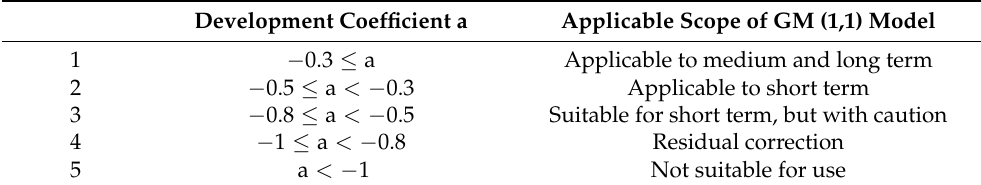
Table 2. The relationship of development coefficient a and applicable scope of GM (1,1) model. Development Coefficient a Applicable Scope of GM (1,1)